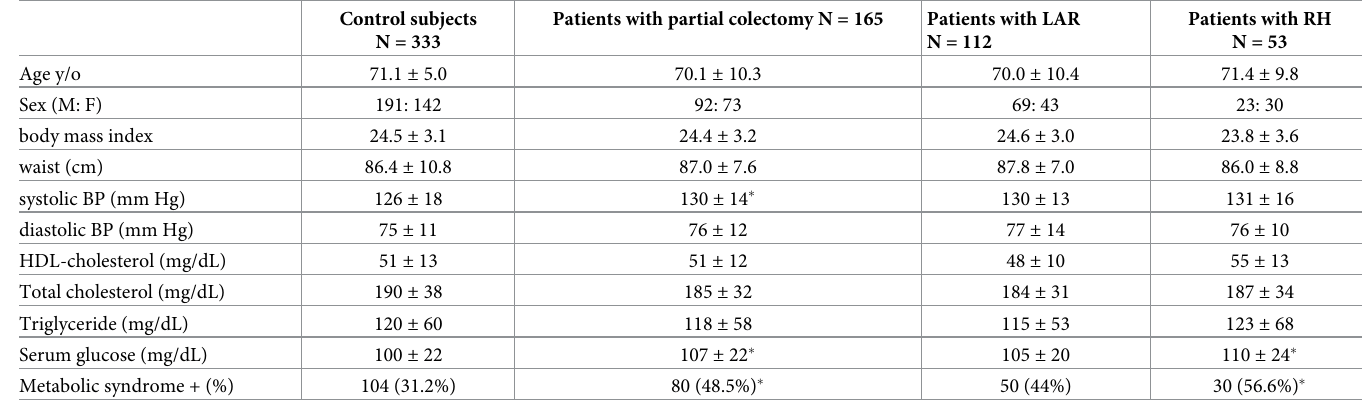
Table 1. Anthropometric and laboratory data between patients with partial colectomy and the control group with a median follow-up of 8.75 years.